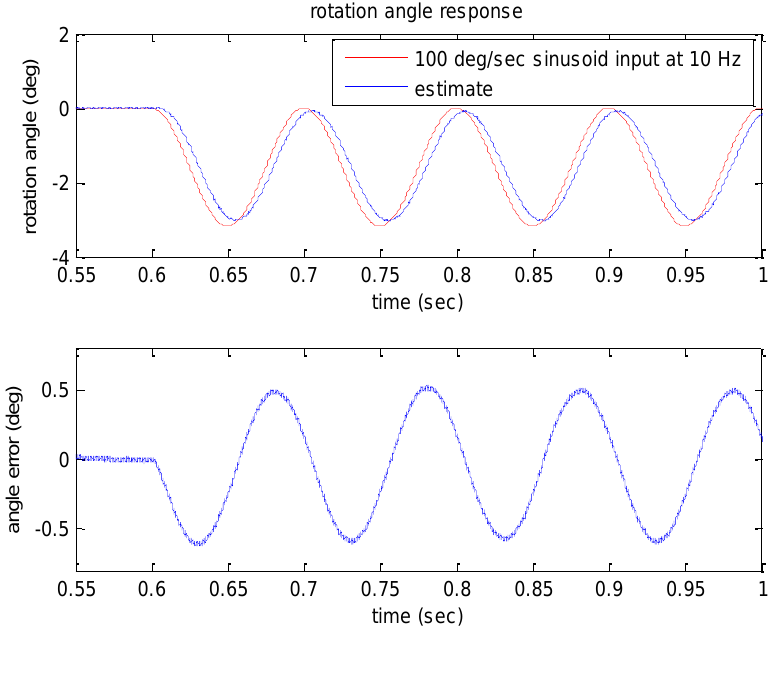
Figure 7. Time response of rotation angle estimate to the 100 deg/s sinusoidal input at 10